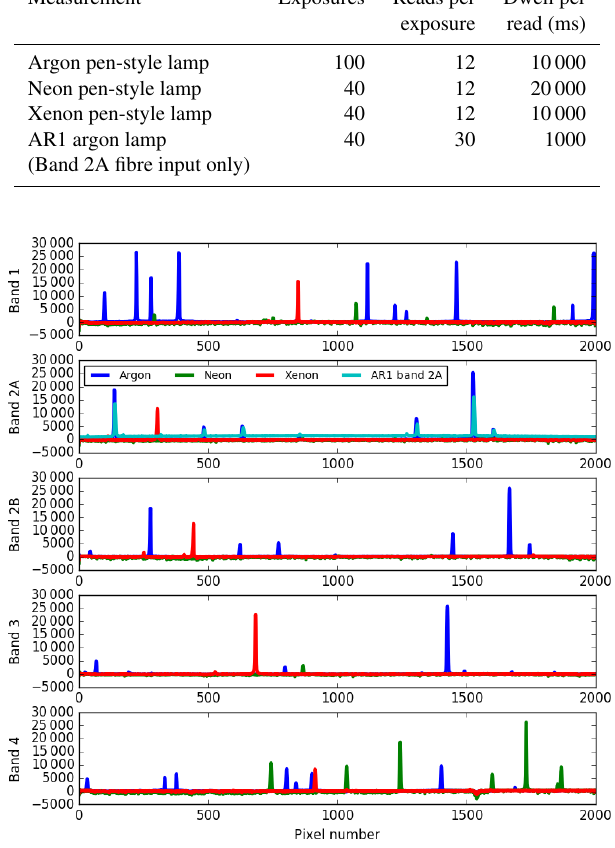
Figure 12. Measurements of emission lamp spectra for each GHOST band, shown as a digital detector response in counts as a function of the horizontal pixel number. The colours correspond to the different emission lamps listed in Table